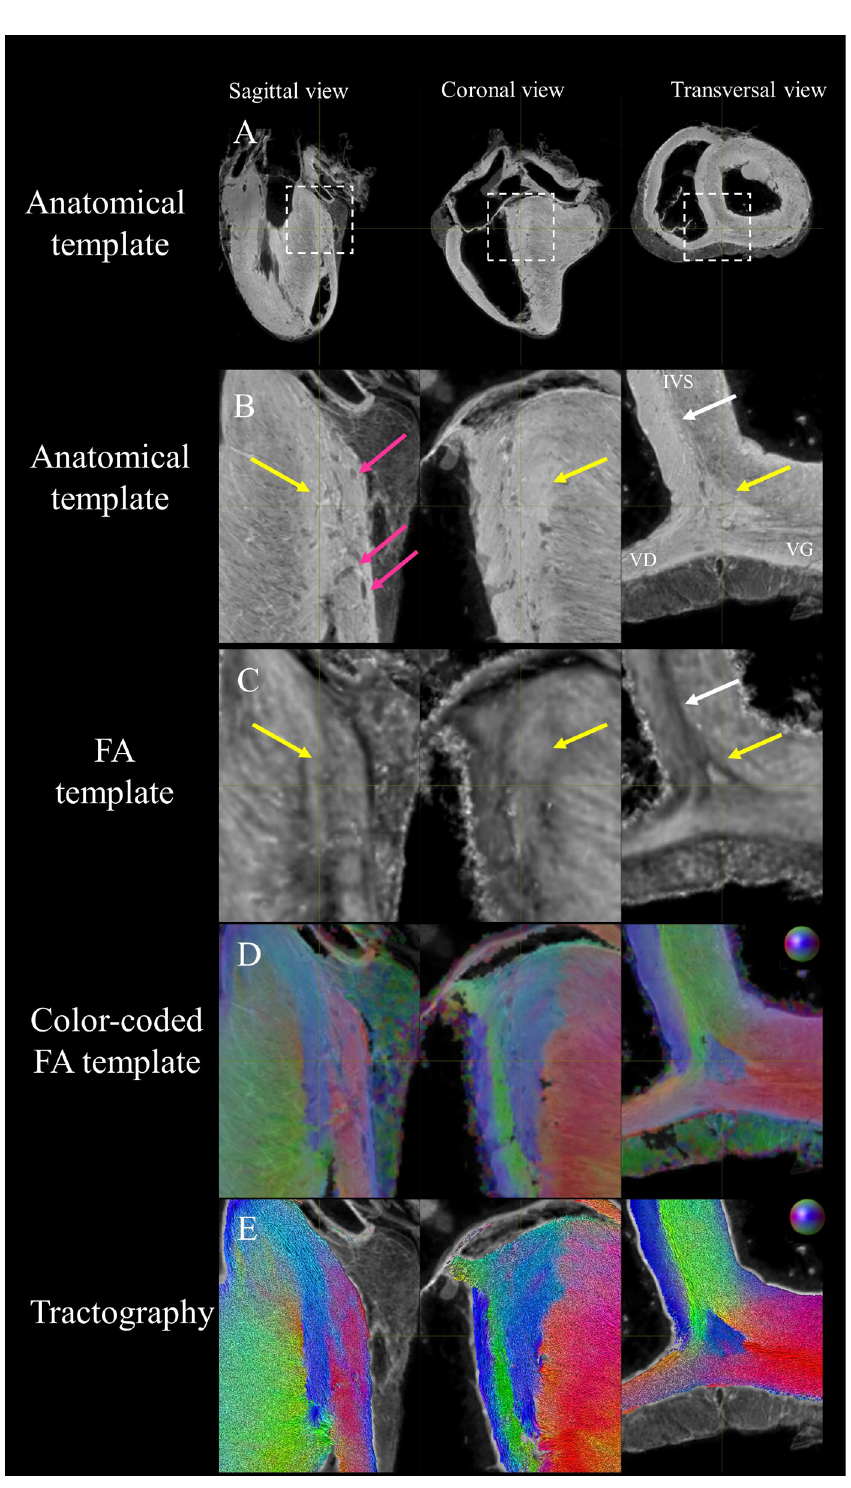
Fig 4. Visualization of the posterior RVIP in the basal area using anatomical, FA and diffusion tensor templates in sagittal, coronal and transverse view. (A) Large view and (B) zoom-view of the anatomical template on the posterior RVIP in the basal area. Myocardium with different gray levels and epicardial fat are visible. (C) FA template. Lower fractional anisotropy value is noticeable. (D) cFA maps overlaid on anatomical data. Smooth transition of fiber orientation is visible (gradient of green to purple) in the endocardial part of the LV while fiber orientation